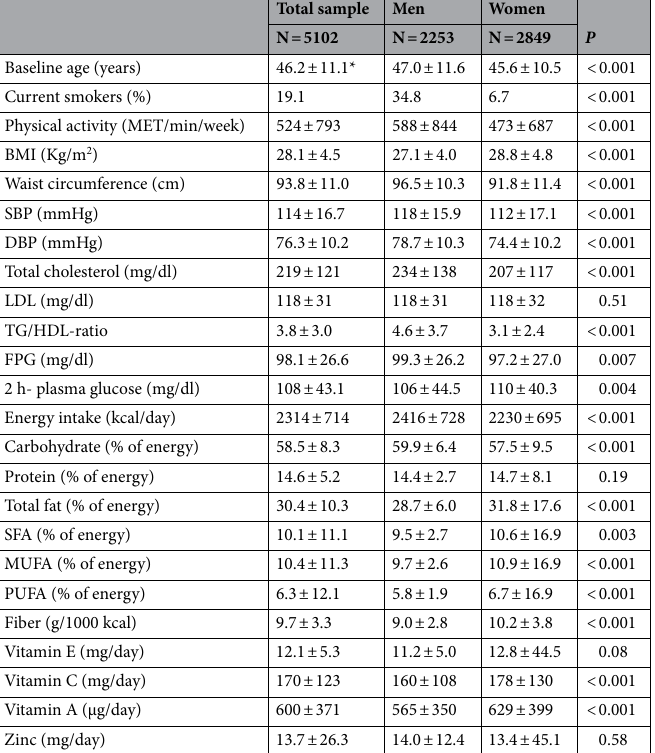
Table 1. Baseline characteristics of adult participants of the Tehran Lipid and Glucose Study. MET, metabolic equivalent; BMI, body mass index; SBP, systolic blood pressure; DBP, diastolic blood pressure; MUFA, mono- unsaturated fatty acids; PUFA, poly-unsaturated fatty acids; SFA, saturated fat. *Values are mean ± SD unless otherwise listed. P values derived through Student’s t-test and chi-square test for quantitative and qualitative variables,